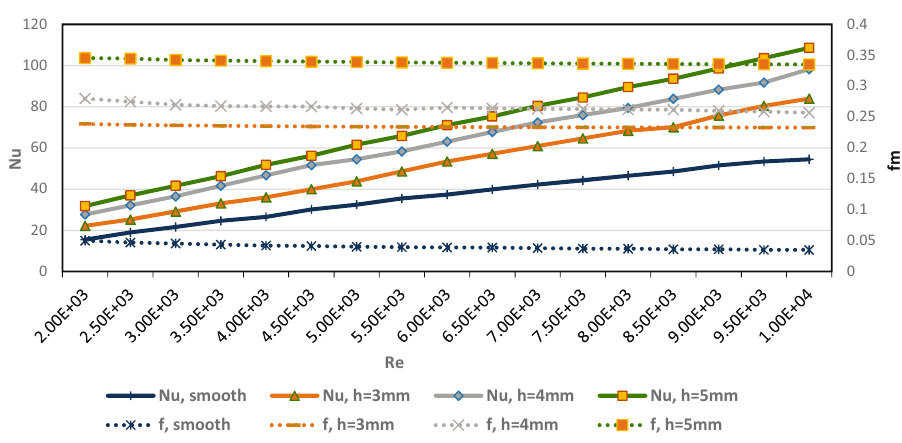
Figure 7: The e ff ect of ba ffl e height on Nusselt number and friction factor.